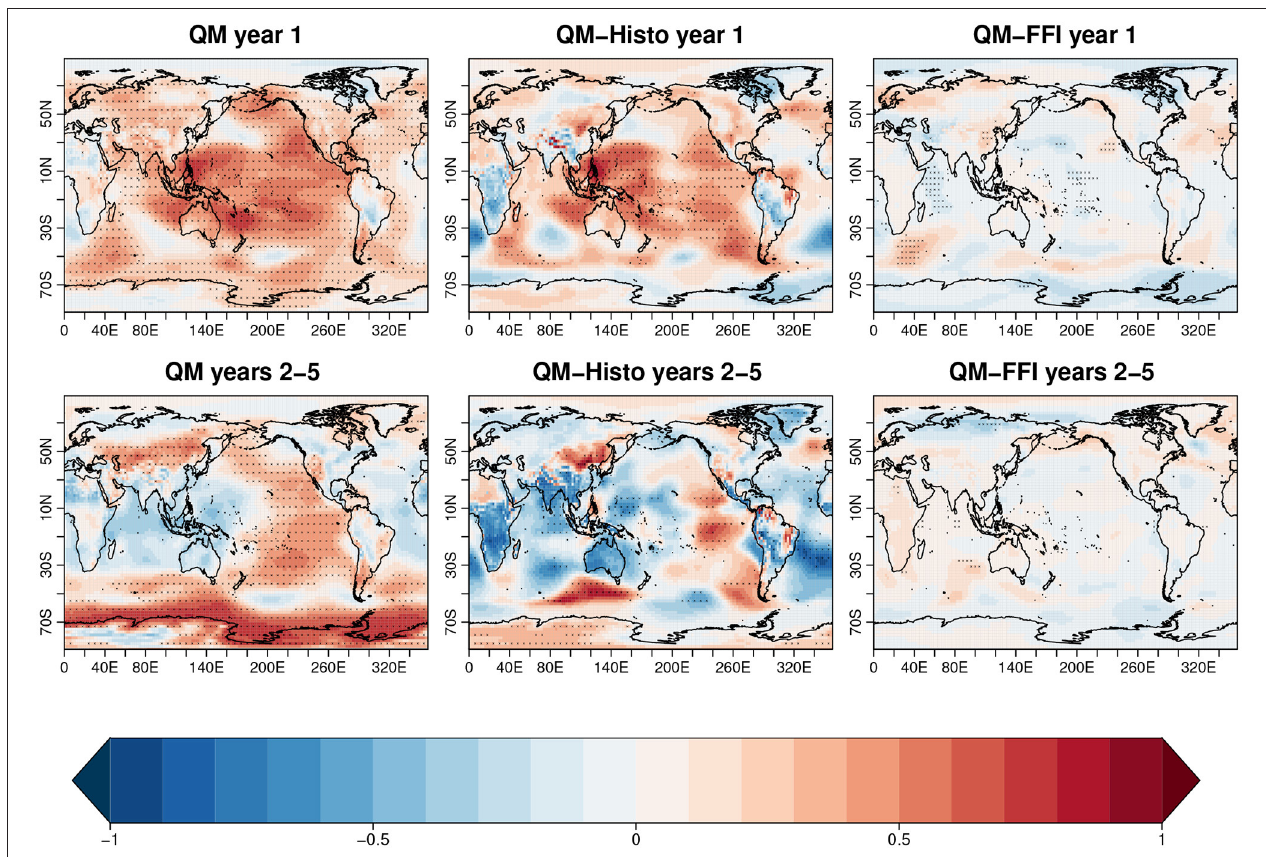
FIGURE 5 | The same as in Figure 4 , but for the sea level pressure. The anomaly correlation (AC) is calculated against ERA-40 and Era-Interim